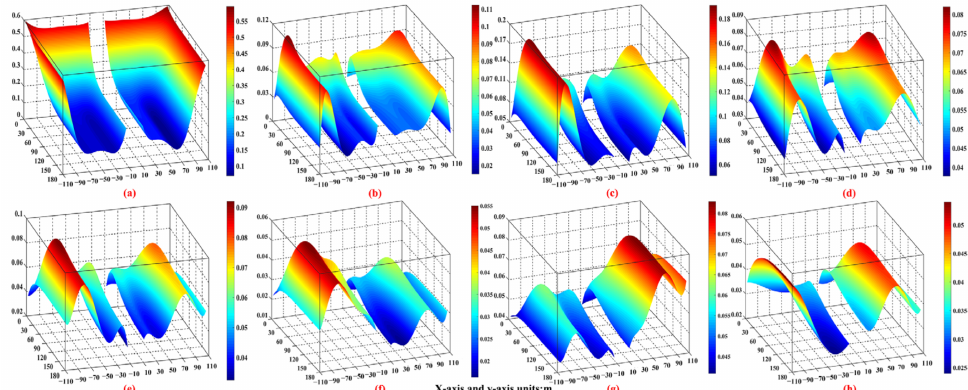
Figure 14. Porosity distribution condition of overlying strata in the GFST. ( a ) No. 16 rock stratum. ( b ) No. 15 rock stratum. ( c ) No. 14 rock stratum. ( d ) No. 13 rock stratum. ( e ) No. 12 rock stratum. ( f ) No. 11 rock stratum. ( g ) No. 10 rock stratum. ( h ) No. 9 rock